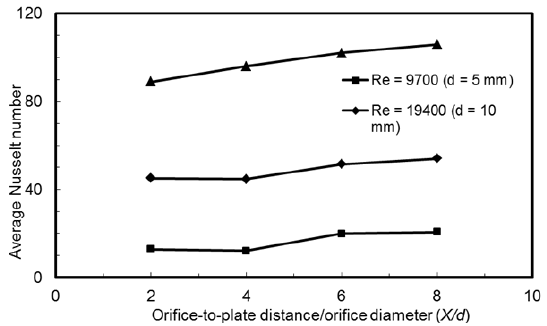
Figure 12. Variation of average Nusselt number with X/d. (jet velocity = 30 m/sec).